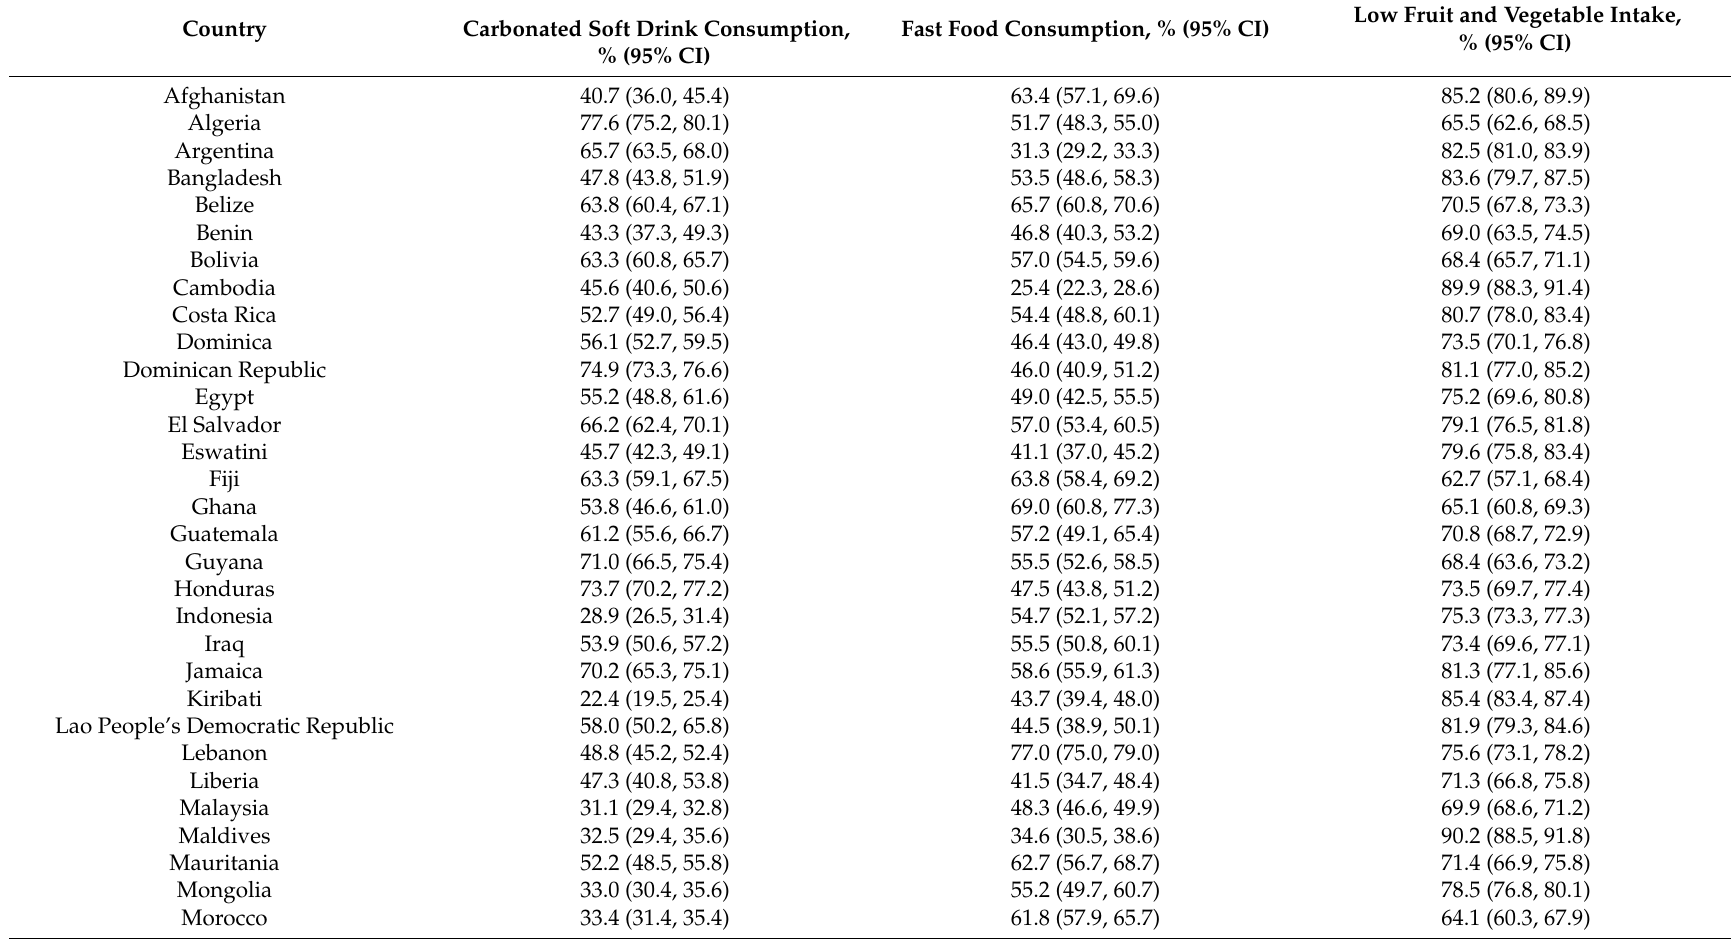
Table 2. Prevalence of fast food consumption, carbonated soft drink consumption, and low fruit and vegetable